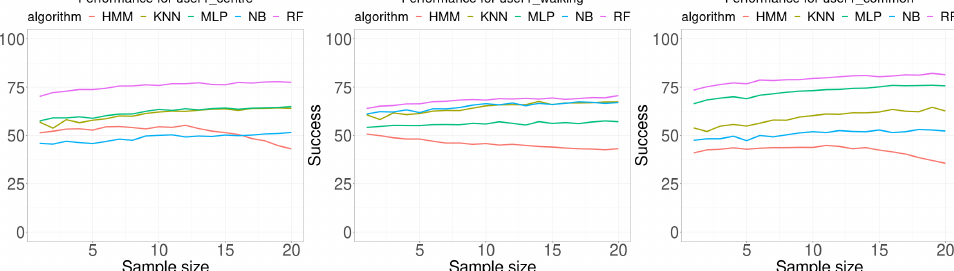
Figure 7. Performance comparison for user 1. Each curve plots the successful rate (percentage) as a function of the number of consecutive samples used for classification (sample size). Each Wi-Fi database contained 100 samples per room for building the model.